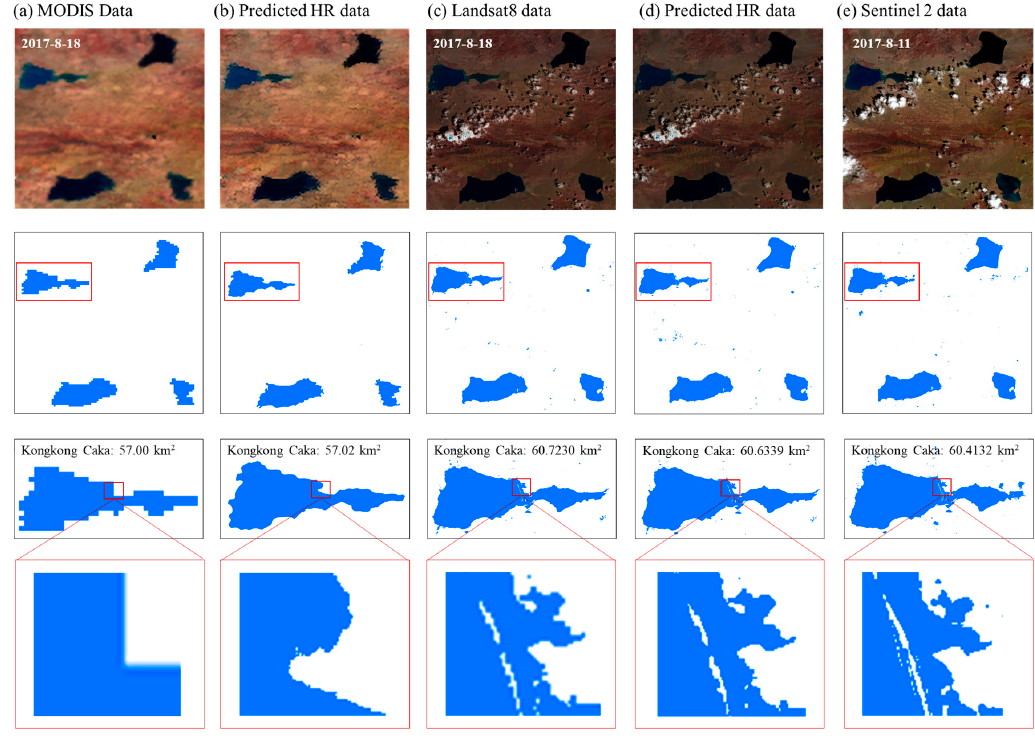
Figure 11. SR Results of MODIS image and Landsat 8 image. ( a ) MODIS data, ( b ) Predicted HR data from MODIS, ( c ) Landsat 8 data, ( d ) Predicted HR data from Landsat 8 data, ( e ) Sentinel 2 data.